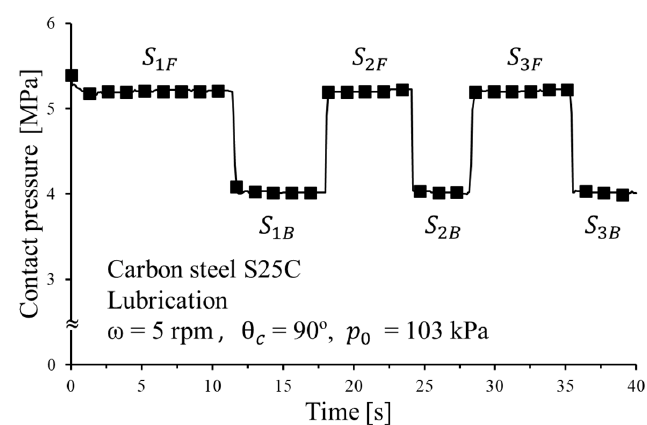
Figure 6. Contact pressure variations during friction tests.